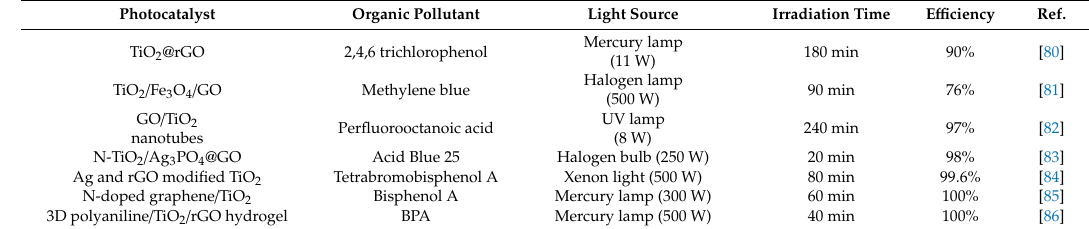
Table 2. Removal percentage of some organic pollutants by TiO 2 / graphene based photocatalysts.